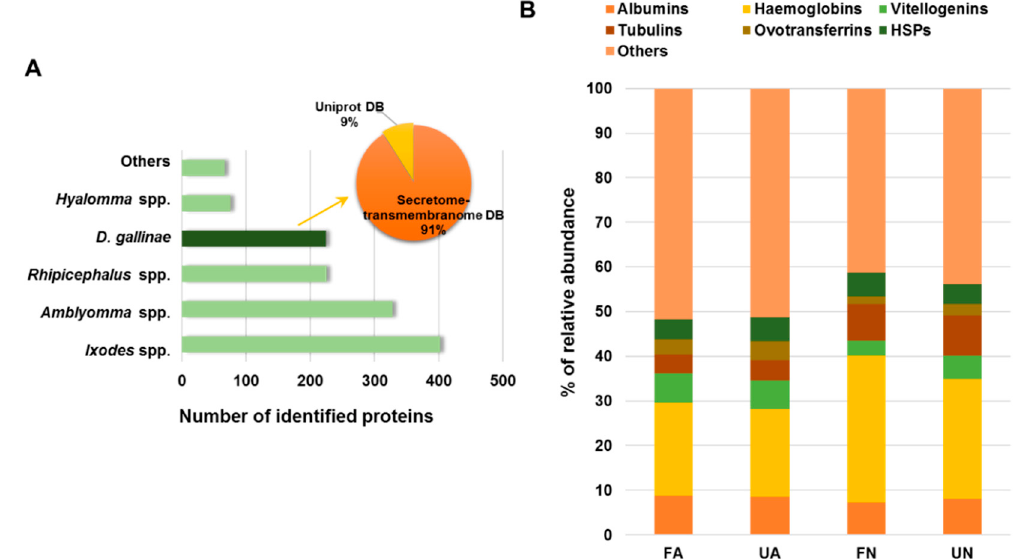
Figure 2. Distribution of PRM and host proteins identified. ( A ) Database assignation distribution of PRM proteins. ( B ) Percent distribution of host proteins calculated with respect to the total number of host PSMs detected in each sample group. FA: engorged female adult mites, UA: non-fed female adult mites, FN: engorged proto- and deutonymphs, UN: unfed proto- and deutonymphs.